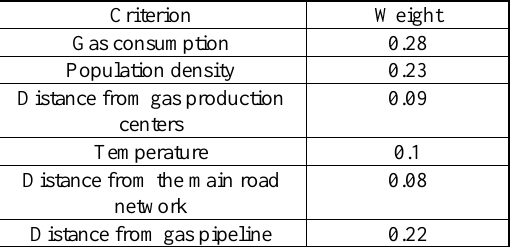
Table 2- Criteria weights computed by Fuzzy-AHP